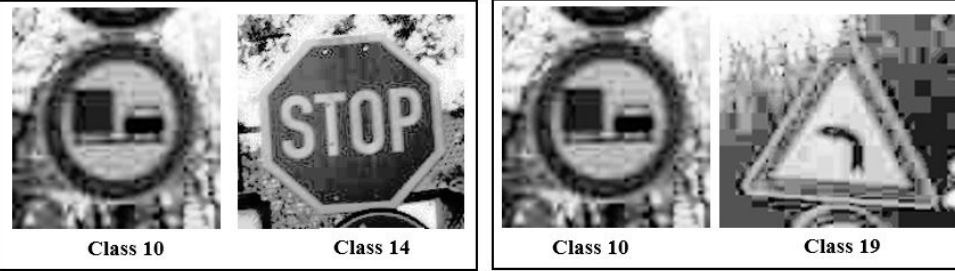
Figure 8. Misclassified classes of 10 and 14 ( left ) and 10 and 19 ( right ). The confusion matrix of the ensemble learning model on the BTSD is depicted in Figure 9. The highest misclassified classes, classes 30 and 35, and the second-highest misclassified classes, between classes 32 and 35, are possibly due to the similarities in the shapes (circles) and symbols of the traffic signs for classes 30 and 35. Samples of the misclassified classes can be viewed in Figure